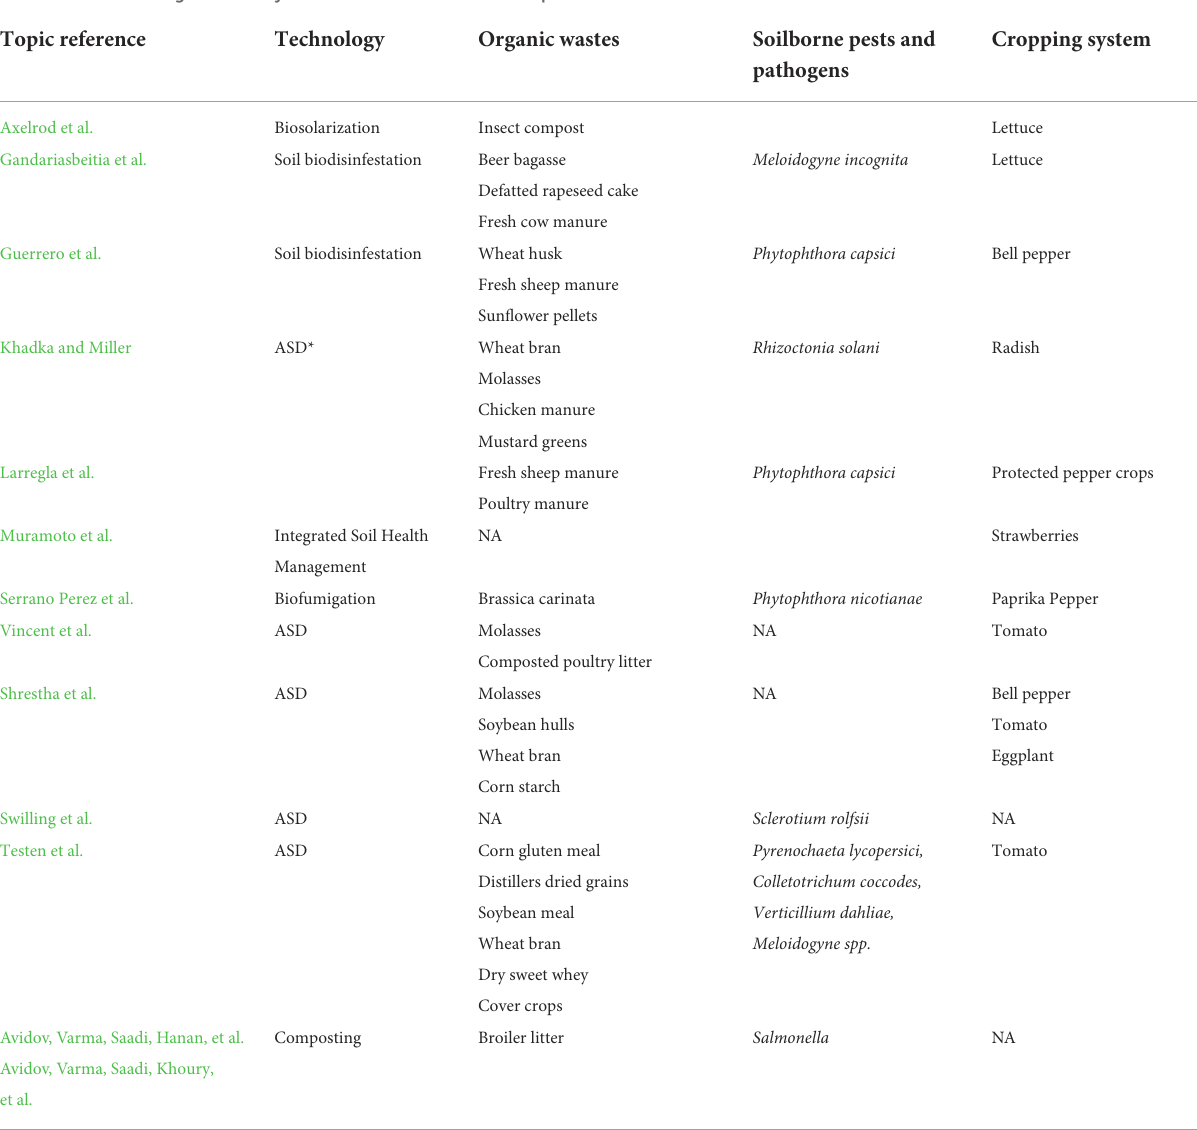
TABLE 1 Summarizing table of key information of the Research Topic articles. Topic